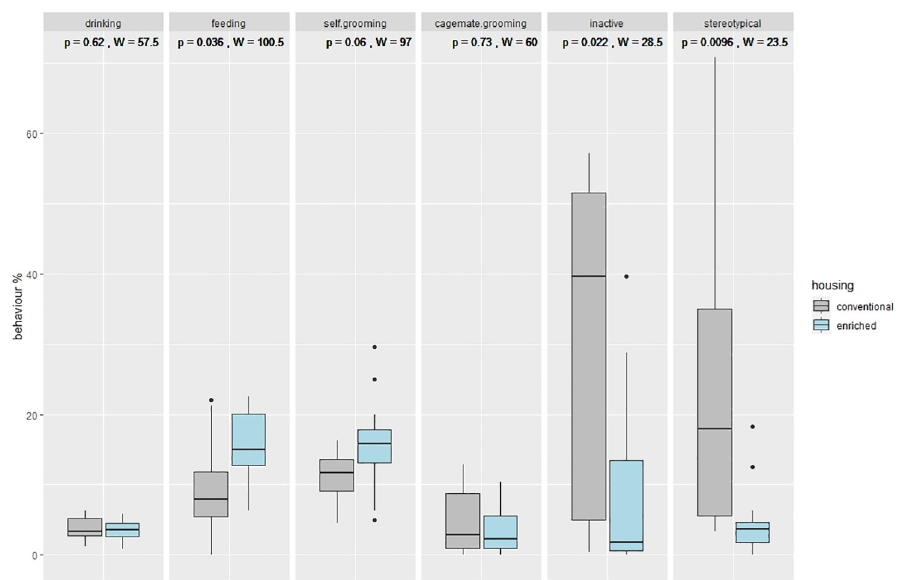
Fig 6. Observed behavior patterns of enriched (n = 12) and conventional housed (n = 11) mice in in % during the active phase. Boxplots depict the median value (horizontal line), the interquartile range from 25th to 75th percentile of the data (box), and the minimum and maximum values lying above or below the box within 1.5 times the interquartile range (vertical lines), outliers ( < q0.25–1.5 x IQR or > q0.75 + 1.5 x IQR) are drawn as filled circles. The p-values of Wilcoxon-test results are above each boxplot. Stereotypical behavior includes scratching, wiping, bar orientated behavior, circling, jumping and route tracing.